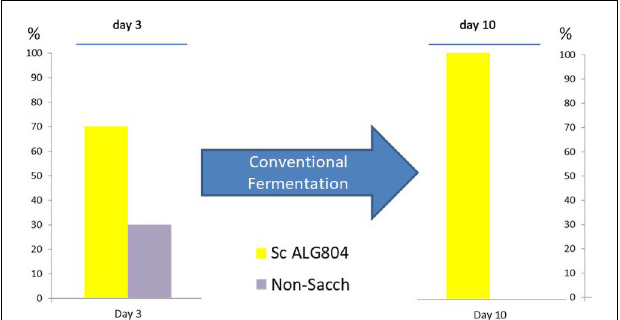
FIGURE 1 | Under conventional wine production, winemakers initiate fermentation by inoculating with a selected commercial strain. Commercial inocula of Saccharomyces strains are well known for efficient initiation of fermentation and typically result in the exclusion of other strains during the course of fermentation [results shown were adapted from Medina et al.